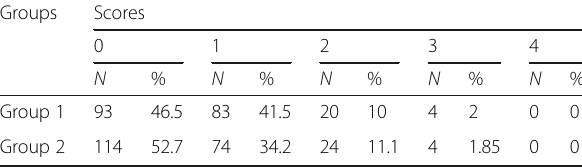
Table 1 Intergroup comparability (chi-square and t tests)